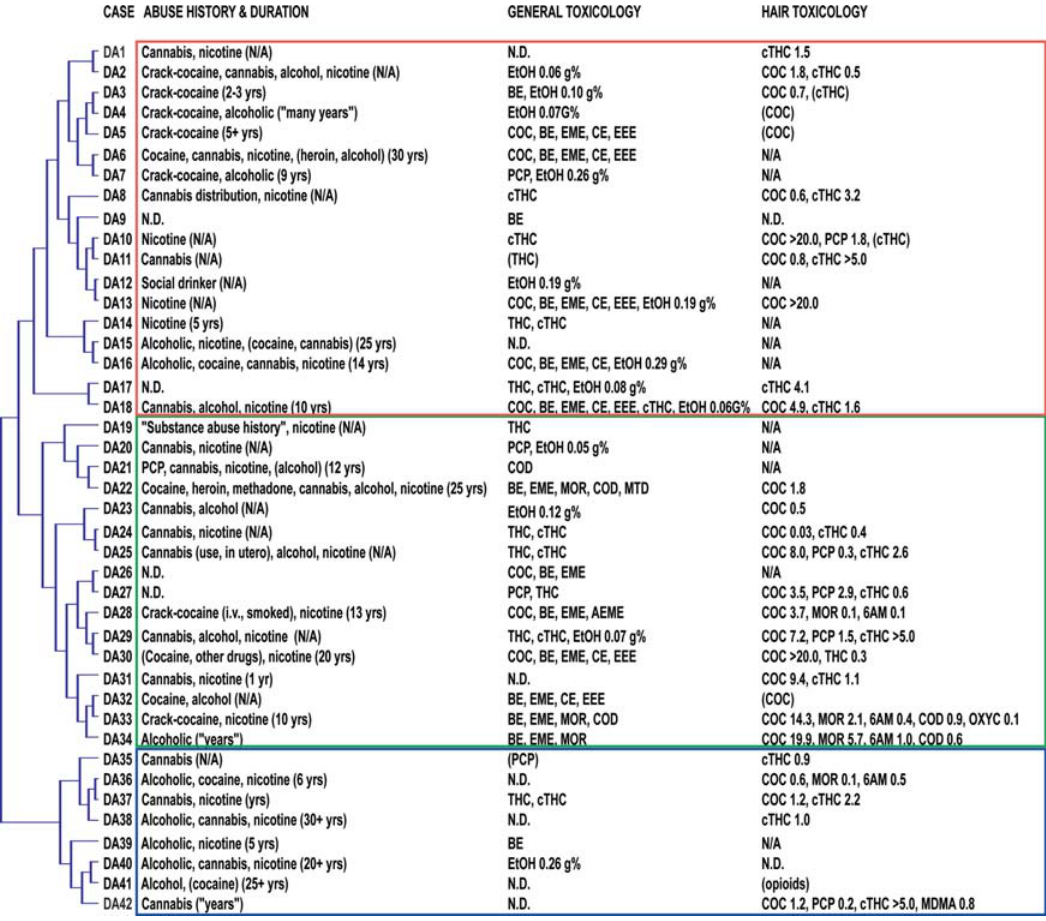
Figure 1. Hierarchical clustering identified three main groups of drug abuse cases . Hierarchical clustering of individual transcriptional profiles from comparisons of drug abuse cases and their individual four best-matched controls identified three main groups of drug abusers: Group I (DA1–18), Group II (DA19–34) and Group III (DA35–42). A summary of toxicology and drug abuse history for each case in the clustering dendrogram indicated cocaine use in a majority of cases, while presence of alcohol in Group I, and opioids and phencyclidine in Group II might underlie differences in Group I and II individuals. Group III cases differed markedly from other cases, which may be related to the absence or low levels of abused drug in most cases, a history of alcohol dependence, or to underlying medical conditions. Insufficient specimen for quantitative analysis of a positive hair test screening is indicated by a parenthesis around the substance name, units are ng/ mg, except for cTHC (pg/mg). Abbreviations: 6AM – 6-acetyl morphine, AEME – anhydroecgonine methyl ester, BE - benzoylecgonine, CE – cocaethylene, COC – cocaine, COD - codeine, cTHC – 11-nor-9-carboxy-tetrahydrocannabinol, EEE – ecgonine ethyl ester, EME – ecgonine methyl ester, EtOH – alcohol, g% - g/dL, MDMA – N-Methyl-3,4-methylenedioxyamphetamine (Ecstasy), MOR – morphine, MTD – methadone, N/A – not available, OXYC – oxycodone, PCP – phencyclidine, THC –